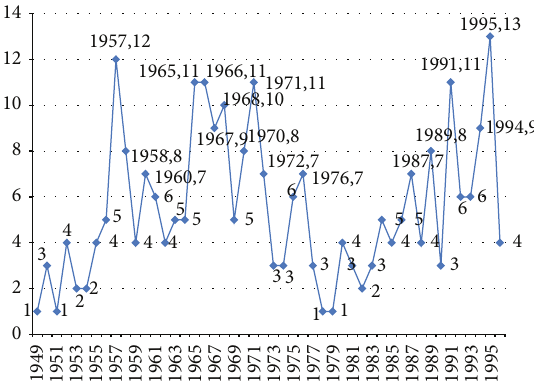
Figure 3: Total cooperative article counts 𝑁 versus year